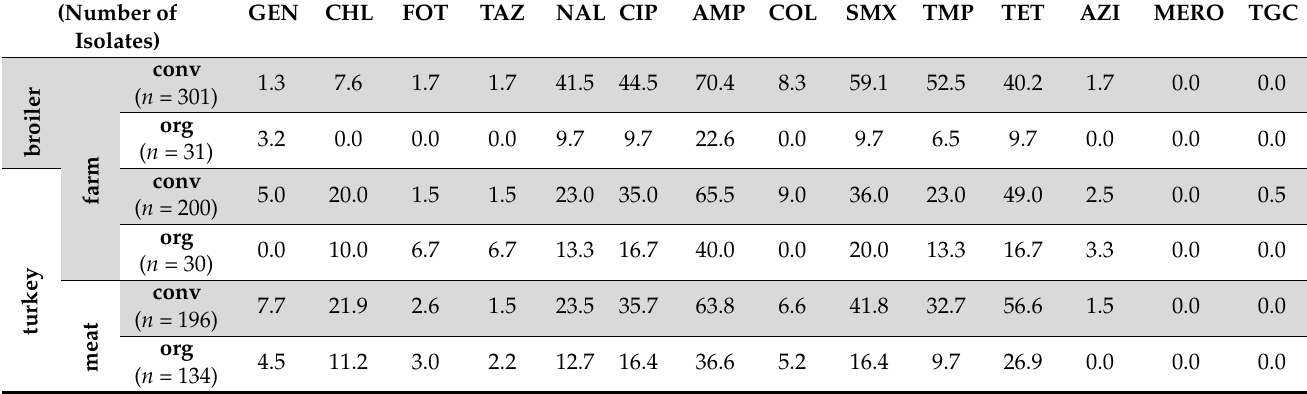
Table 1. Percentage of isolates resistant to an antimicrobial substance (conv = conventional farm- ing, org = organic farming, GEN = gentamicin, CHL = chloramphenicol, FOT = cefotaxime, TAZ = ceftazidime, NAL = nalidixic acid, CIP = ciprofloxacin, AMP = ampicillin, COL =